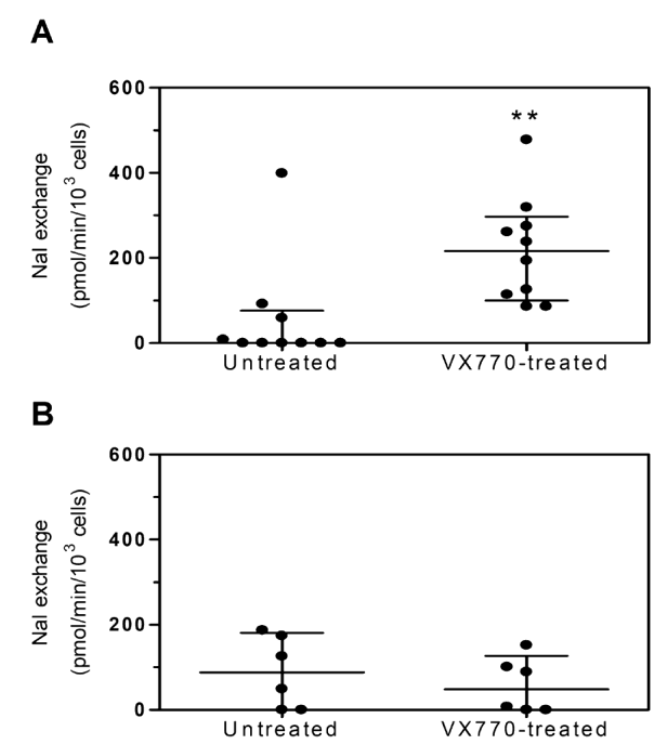
Figure 3. CFTR activity in PBMCs following ex vivo cell treatment with VX770. CFTR activity was measured in PBMCs isolated from CF patients ( n = 16) and exposed for 24 h to either vehicle (untreated) or 5 µ M VX770 (VX770-treated). ( A ) Responsive CF patients’ PBMCs ( n = 10). ( B ) Unresponsive CF patients’ PBMCs ( n = 6). Data are expressed as the median with interquartile range. Statistical analysis was carried by means of the Wilcoxon signed rank test. ** p < 0.01.